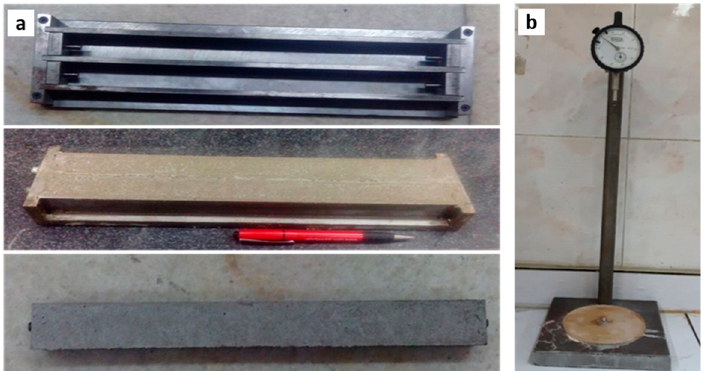
Figure 1. Accelerated mortar bar samples (ASTM C 1260): ( a ) casting equipment and mortar bars; ( b ) length measurement facility.